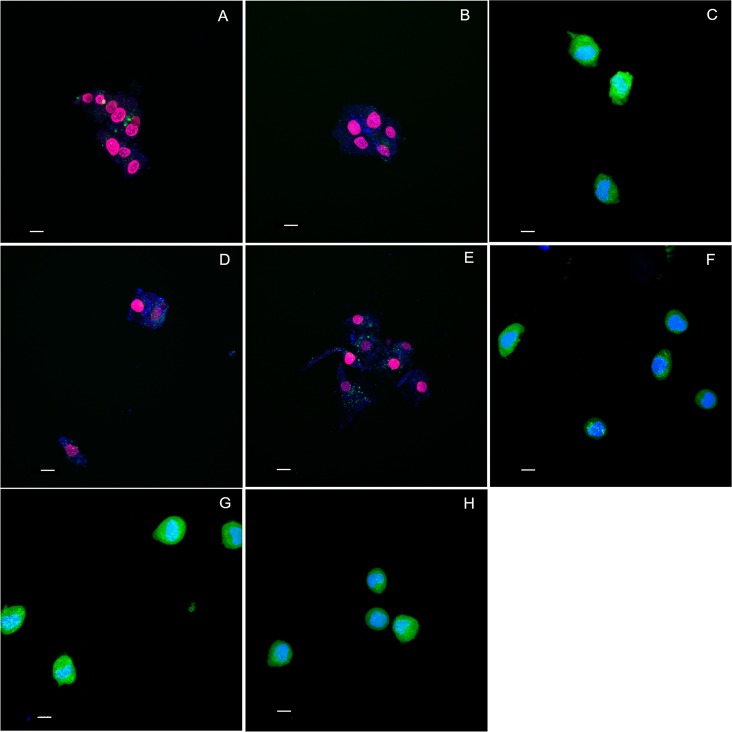
Step 2.Representative confocal images of the 24 h varnishes’ treatments. (A) 4.00% TiF4, (B) 3.10% TiF4, (C) 1.50% TiF4, (D) 5.42% NaF, (E) 4.20% NaF, (F) 2.10% NaF, (G) Control, (H) Placebo. 4.00% TiF4 and 5.42% NaF (2.45% F); 3.10% TiF4 and 4.20% NaF (1.90% F); 1.50% TiF4 and 2.10% NaF (0.95% F). Scale bar, 10 μm.